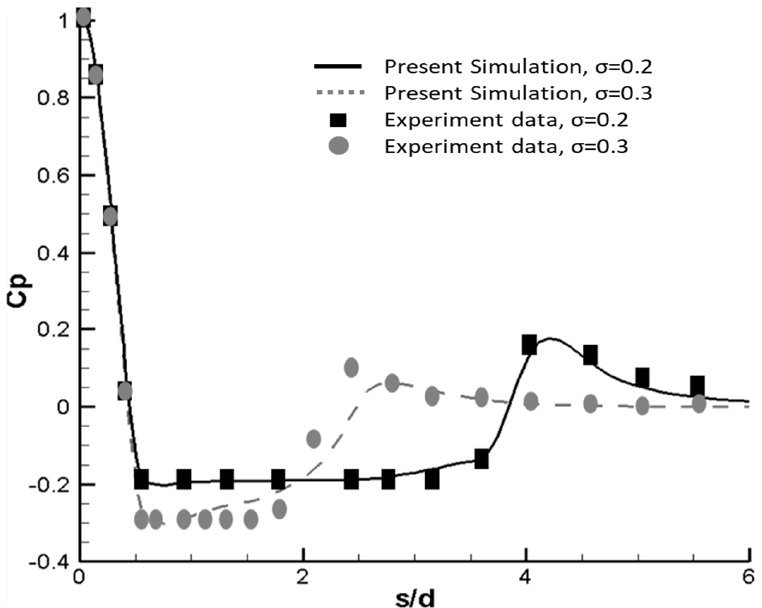
Figure 2. Surface pressure coe ffi cient on the hemispherical head cylinder at various cavitation numbers.